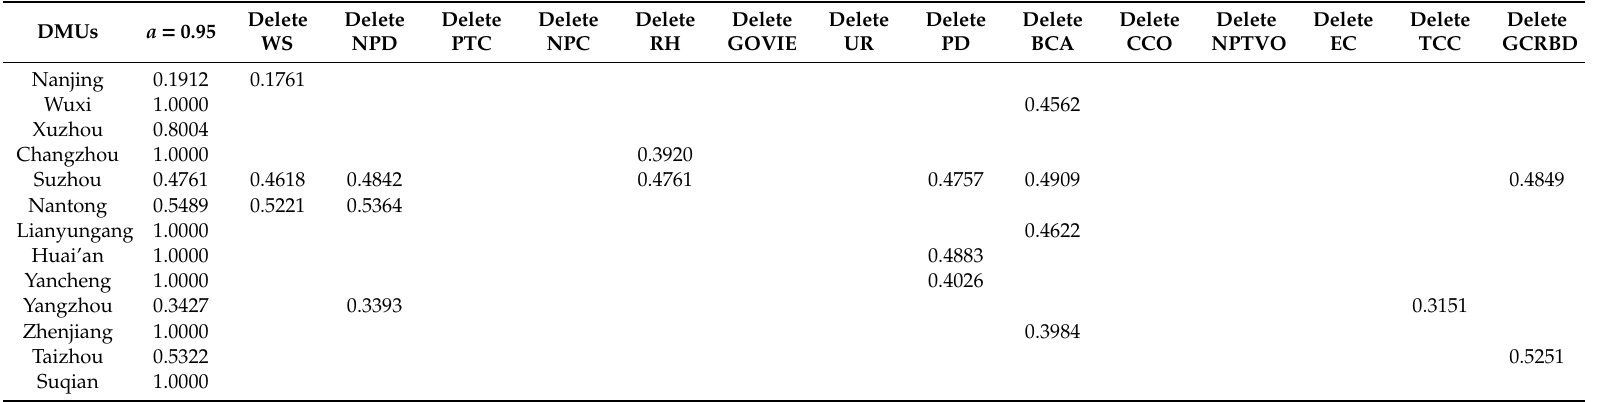
Table A6. The changes of stochastic e ffi ciency value by deleting single input variable in 2015 ( α = 0.95).